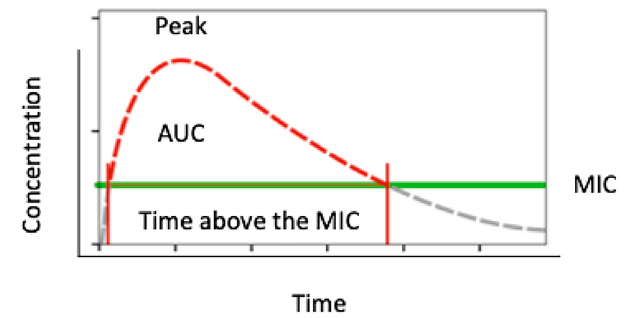
Figure 2. Figure showing pharmacodynamics of a time-dependent antibiotic.